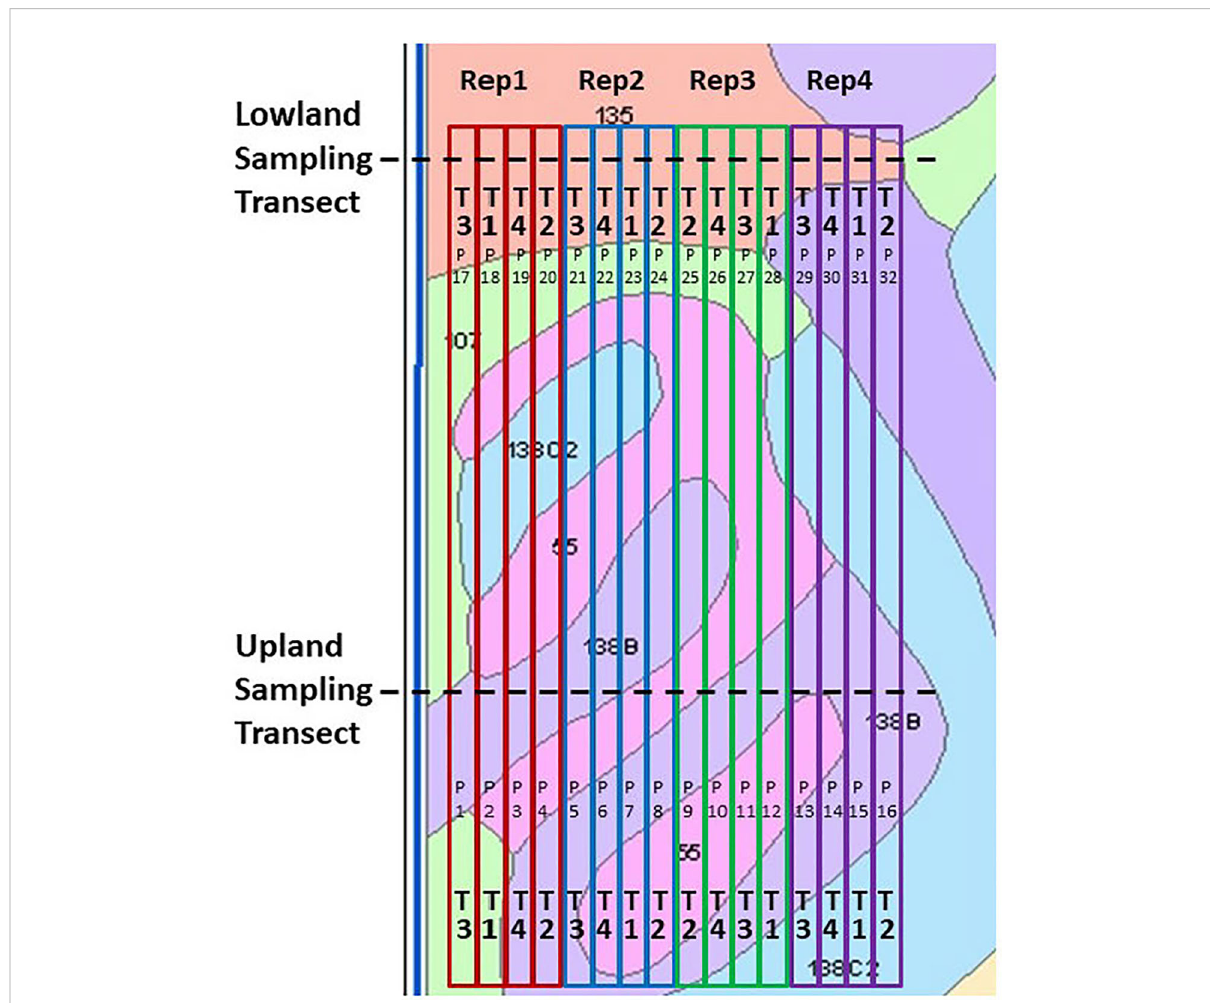
FIGURE 2 Field design of the Ames on-farm fi eld research site, shown with soil mapping units and boundaries of the fi eld-long treatment strips. Key to treatments ( “ T ” ): T1, Control lacking Enersol humic product application; T2, lower rate of Enersol humic product application at the fourth maize leaf stage; T3, split application (2012, 2014) or higher rate (2016) of humic product application; and T4, a separate alkali-extracted humic product. Plot numbers are shown as “ P ” . Key to soil mapping units: 55, Nicollet loam, 1 to 3 percent slopes; 107, Webster silty clay loam, 0 to 2 percent slopes; 135, Coland clay loam, 0 to 2 percent slopes, 138B, Clarion loam, 2 to 5 percent slopes; and 138C2, Clarion loam, 5 to 9 percent slopes, moderately eroded. Reprinted from Olk et al.